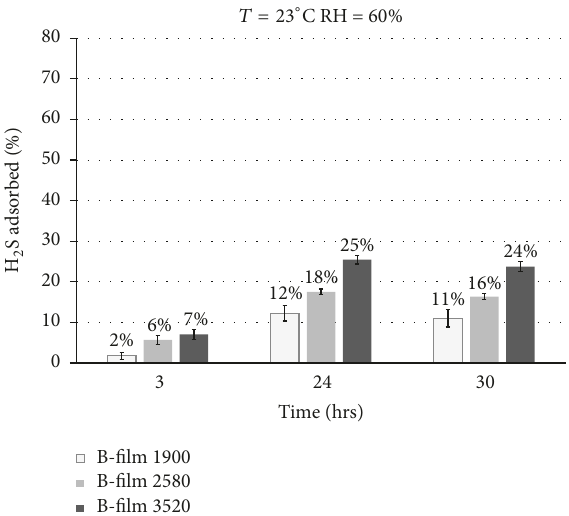
Figure 4: Adsorbed H 2 S (%) at specific time intervals at a storage temperature of 23 ∘ C and humidity of 20%. The bag tested was with thefilmsheetsinside. Thesurfaceof theinternal filmsheet was equal to 1900 cm 2 (B-film 1900), 2580 cm 2 (B-film 2580), and 3520 cm 2 (B-film 3520), respectively. The data reported are the average of the results from three different tests performed at the same conditions.